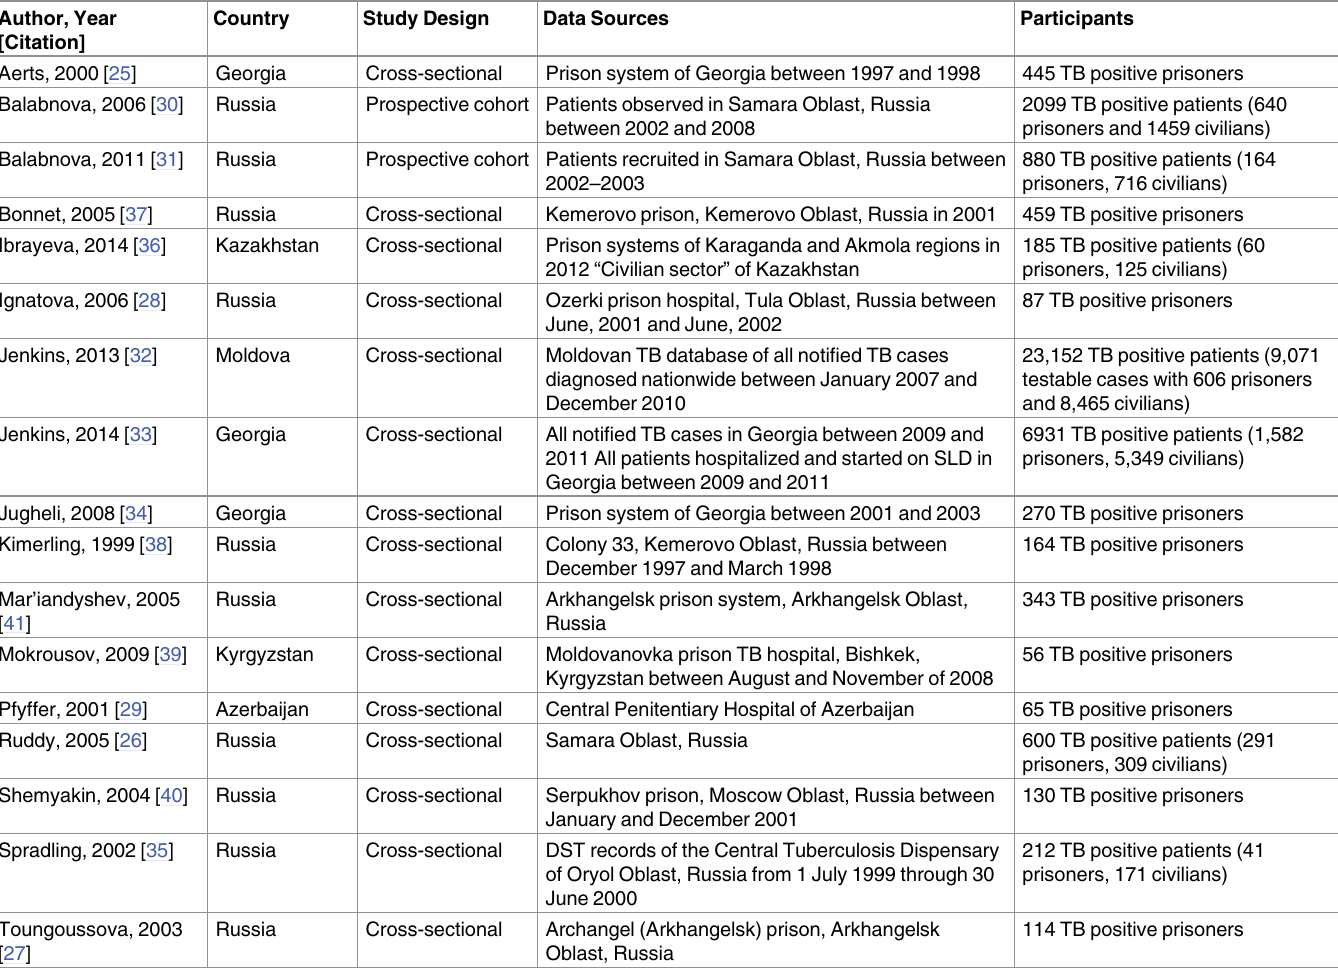
Table 1. Characteristics of included